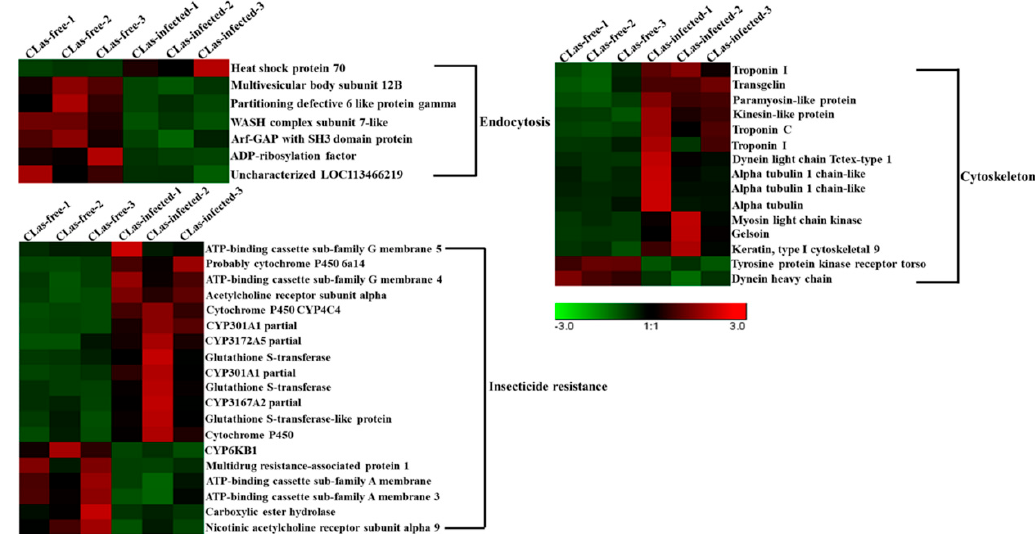
Figure 7. Hierarchical analysis for DEGs associated with endocytosis, the cytoskeleton and insecticide resistance between C Las-free and C Las-infected D. citri midgut. A hierarchical cluster analysis was performed using the Genesis software. DEG expression is shown with a pseudocolour scale (from − 3 to 3), with the red colour indicating high expression levels and the green color indicating low expression. Each group represents three biological replicates. Table 3. Differentially expressed genes upon CLas infection involved in endocytosis, the cytoskeleton and insecticide resistance, comparing C Las-infected groups and C Las-free groups.